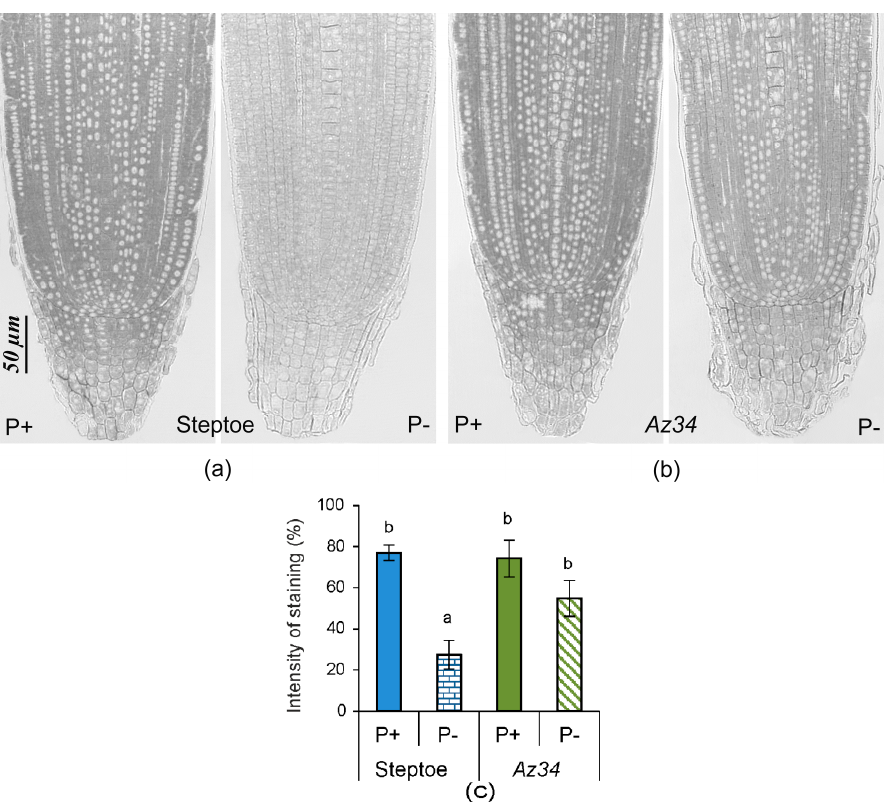
Figure 9. Immunolocalization of free zeatin in root tips of 4-days-old barley seedlings (cv. Steptoe ( a ) and Az34 ( b )) grown for 1 day on the nutrient solutions with (P+) or without (P − ) phosphate. Scale bars 50 µm. The intensity of staining was evaluated in the area shown for Figure 5a. Diagram ( c ) presents the results of a semi-quantitative assay of the intensity of staining of the tips of the root of Steptoe and Az34 plants obtained with the help of the ImageJ program [44]. Images were taken from 15 independent sections per genotype or treatment. The intensity of staining was expressed in arbitrary units, with maximal staining taken as 100% and minimal as 0 with different letters above the bars indicating significant ( p < 0.05) differences according to ANOVA (LSD).